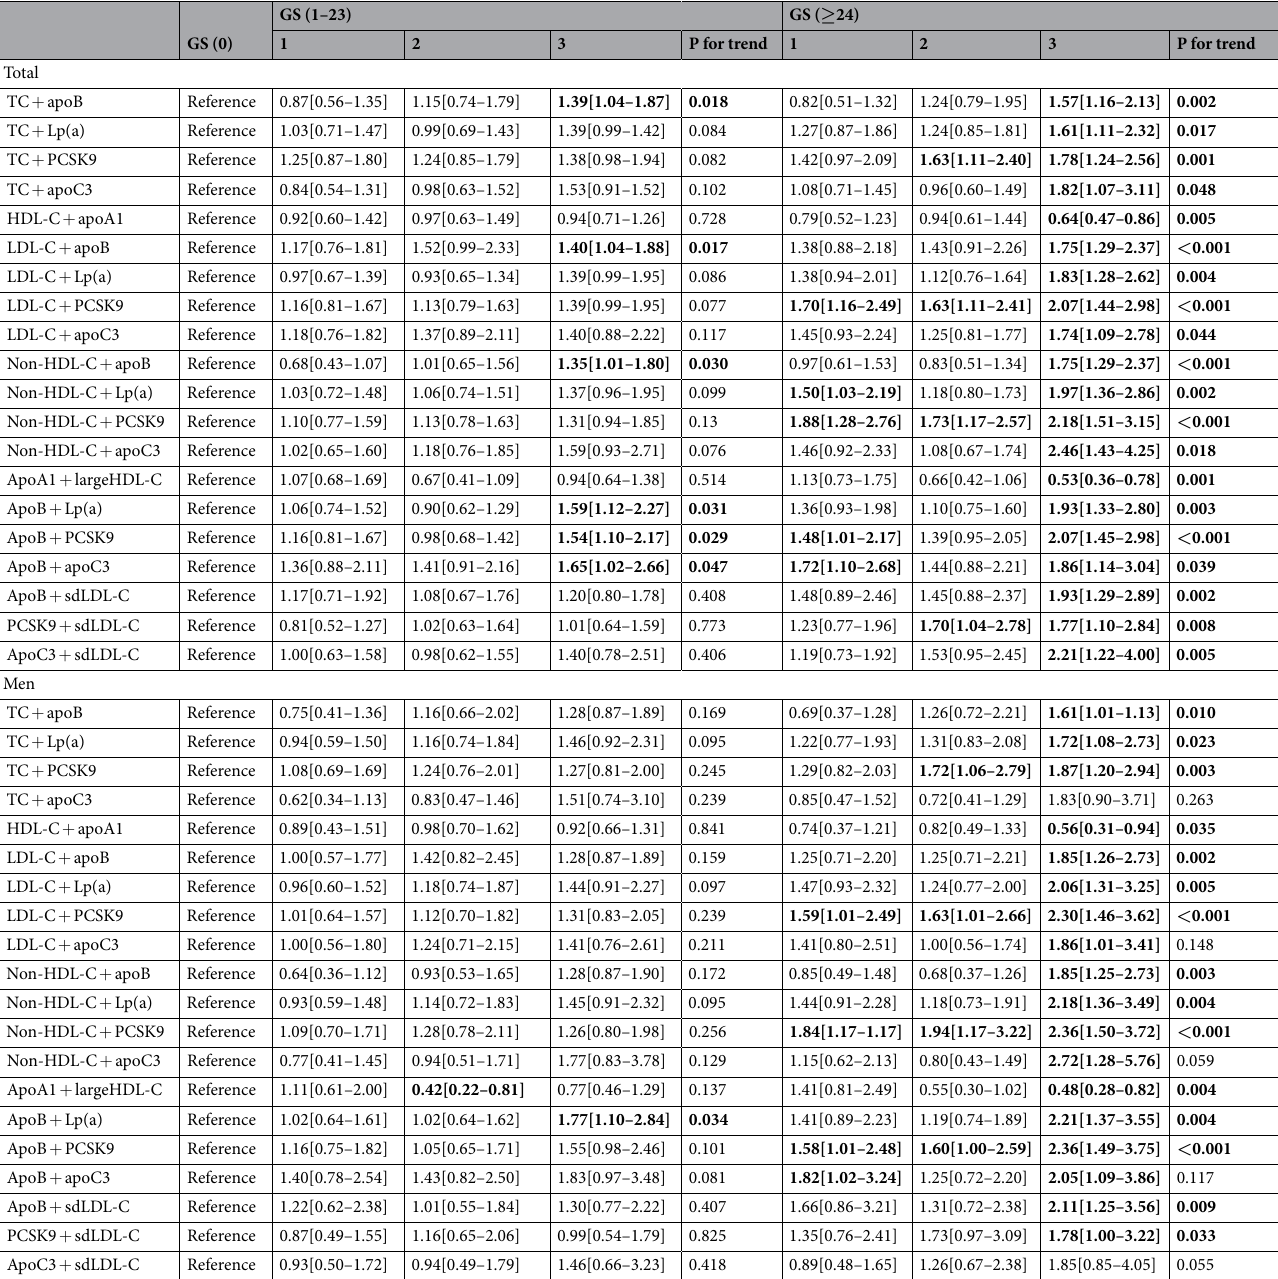
Table 6. Associations of lipid combinations with coronary severity using Logistic regression analysis. Multiple ordinal logistic regression analyses were performed, ORs [95% CIs] were showed with adjustment for age, gender, hypertension, HbA1c, current smoking and hs-CRP. GS status was the dependent variable with the group of GS = 0 as reference status. Lipid categories of the two biomarkers were the independent variable, and 4 groups were included based on the medians of their levels: low/low (less than the medians of both), high/ low (greater than or equal to the median of the prior but less than the median of the posterior), low/high (less than the median of the prior but greater than or equal to the median of the posterior) and high/high (greater than or equal to both the medians). The OR of low/low was 1 and not shown in the Table. The medians of their levels were 4.77 mmol/L (TC), 1.04 mmol/L (HDL-C), 3.07 mmol/L (LDL-C), 3.67 mmol/L (non-HDL-C),